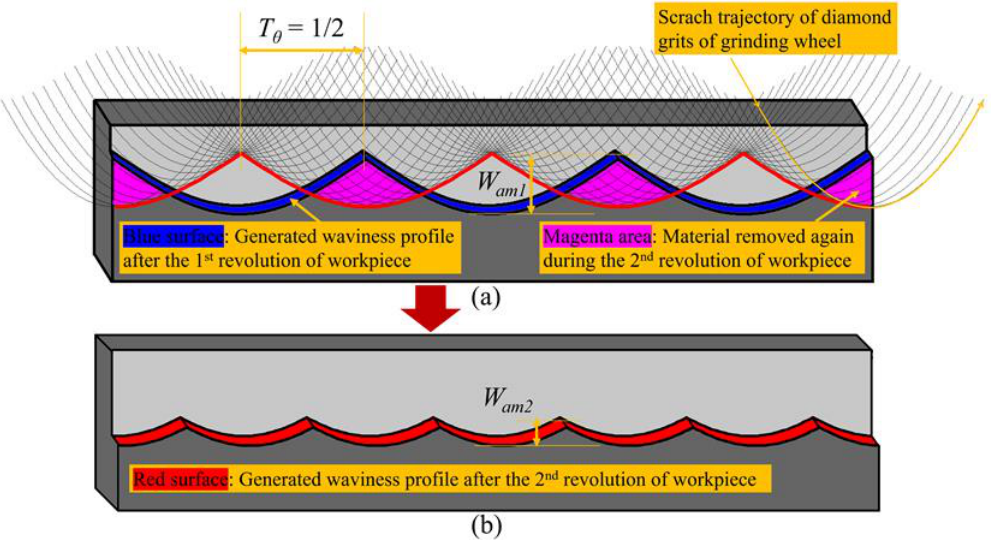
Figure 7. Suppression mechanism of the surface waviness amplitude when using non-integer RSR. ( a ) removing material again by the secondary grinding zone during the 2nd revolution of workpiece; ( b ) generated waviness profile after the 2nd revolution of workpiece.